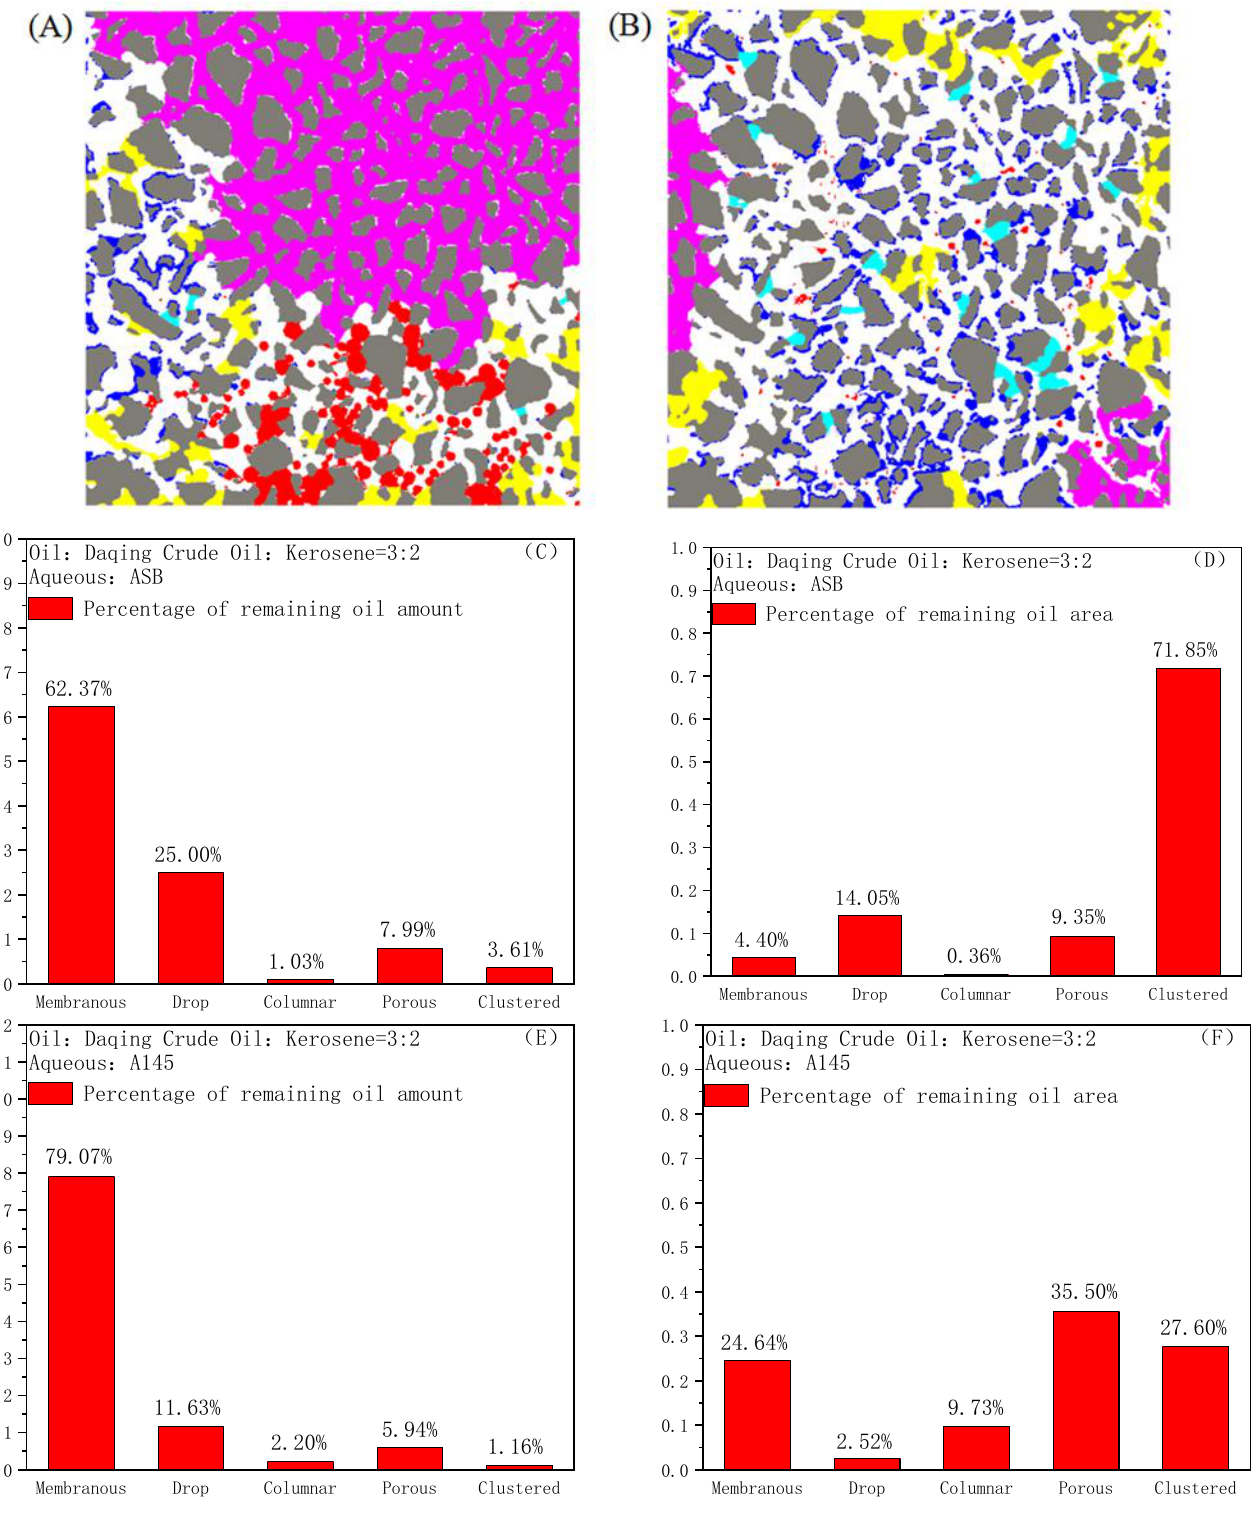
Figure 8. The remaining oils after ASB ( A ) and A1045 ( B ) flooding in simulated homogeneous model; The amount ( C ) and area ( D ) distributions of remaining oil types after ASB flooding; The amount ( E ) and area ( F ) distributions of remaining oil types after A145 flooding.